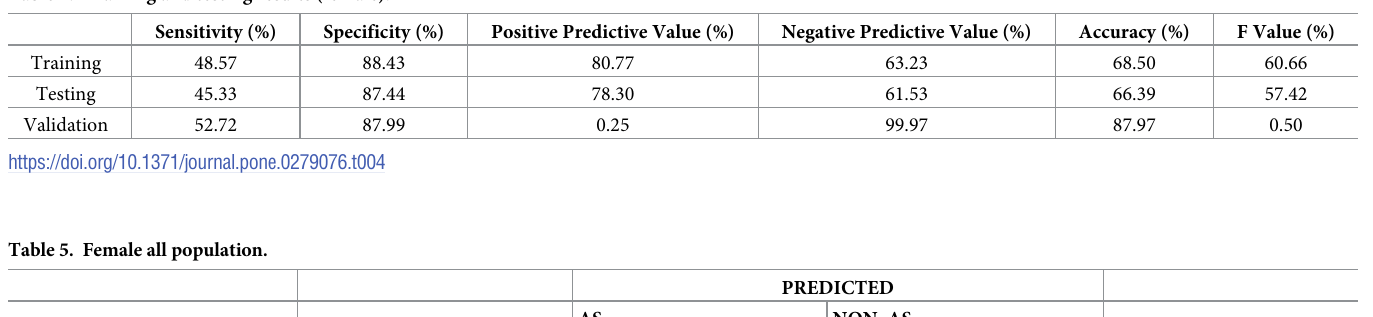
Table 4. Training and testing results (female).